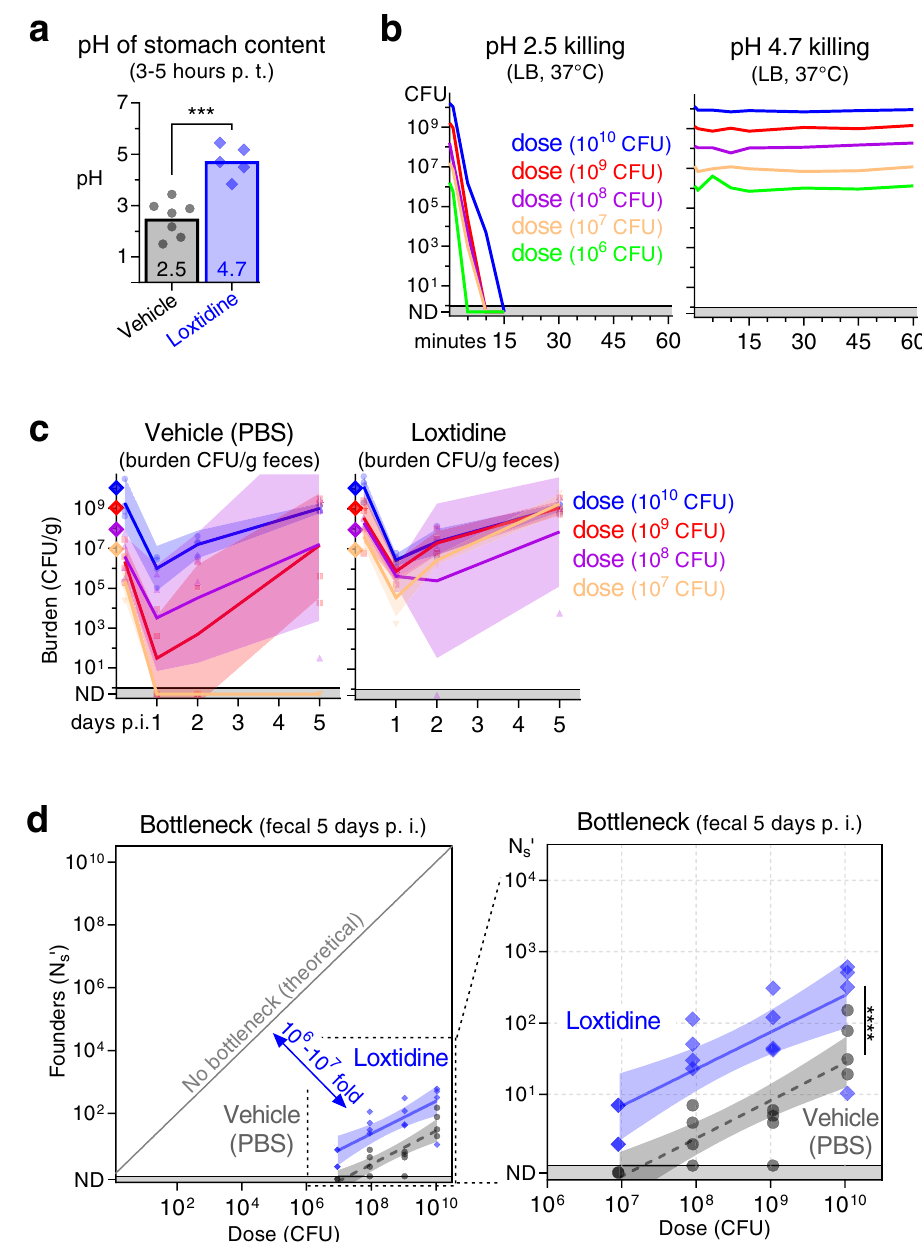
Fig.3|Stomachacidconstrictsthe C.rodentium populationby10-to100-fold. a The effect of Loxtidine on stomach acid in C57BL/6 J mice 3 – 5h after intraperitoneal administration of 1mg in 0.1 ml PBS. pH determined post- mortem in aspirated stomach fl uid. Boxes arithmetic mean (2.5 for mock and 4.7 for Loxtidine). Two-tailed t test with p -value 0.0002. Animals are 7 (vehi- cle) and 5 (Loxtidine). b The acid tolerance of STAMP-CR69K in culture measured by diluting cells in LB at pH 2.5 or 4.7 and incubating at 37 °C with shaking. pH 2.5 sterilized 10 10 CFU in 15min. c , d 3 – 5h after intraperitoneal administration of PBS (vehicle) or Loxtidine (1 mg), C57BL/6J mice were